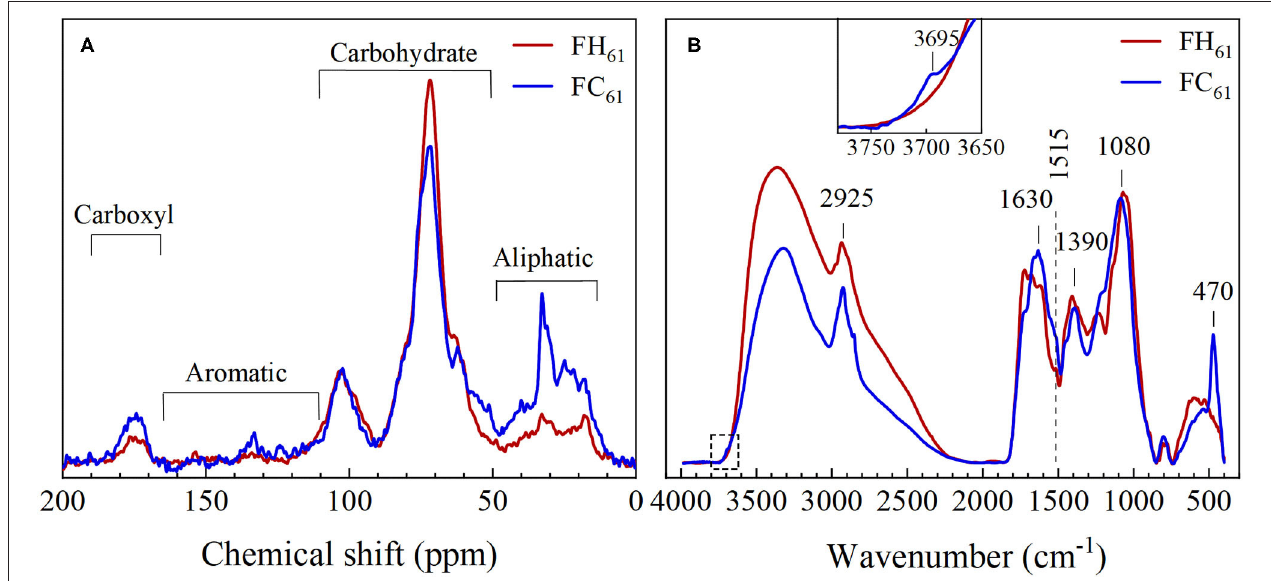
FIGURE 2 | Solid-state spectroscopic characterization of FH 61 (red line) and FC 61 (blue line) by (A) solid-state 13 C NMR and (B) diffuse reflectance IR spectroscopy. NMR spectra of all samples are shown in Supplementary Figure S1 . IR spectra were normalized to the area between 2,000 and 400 cm − 1 . The inset in panel (B) highlights a diagnostic clay mineral peak at 3,695 cm − 1 . The dashed vertical line at 1,515 cm − 1 highlights the presence of aromatic lignin-like compounds. IR spectra of all samples are shown in Supplementary Figure S2 . Tentative assignments of the principal IR bands are provided in Supplementary Material S1.3 ; Supplementary Table S2